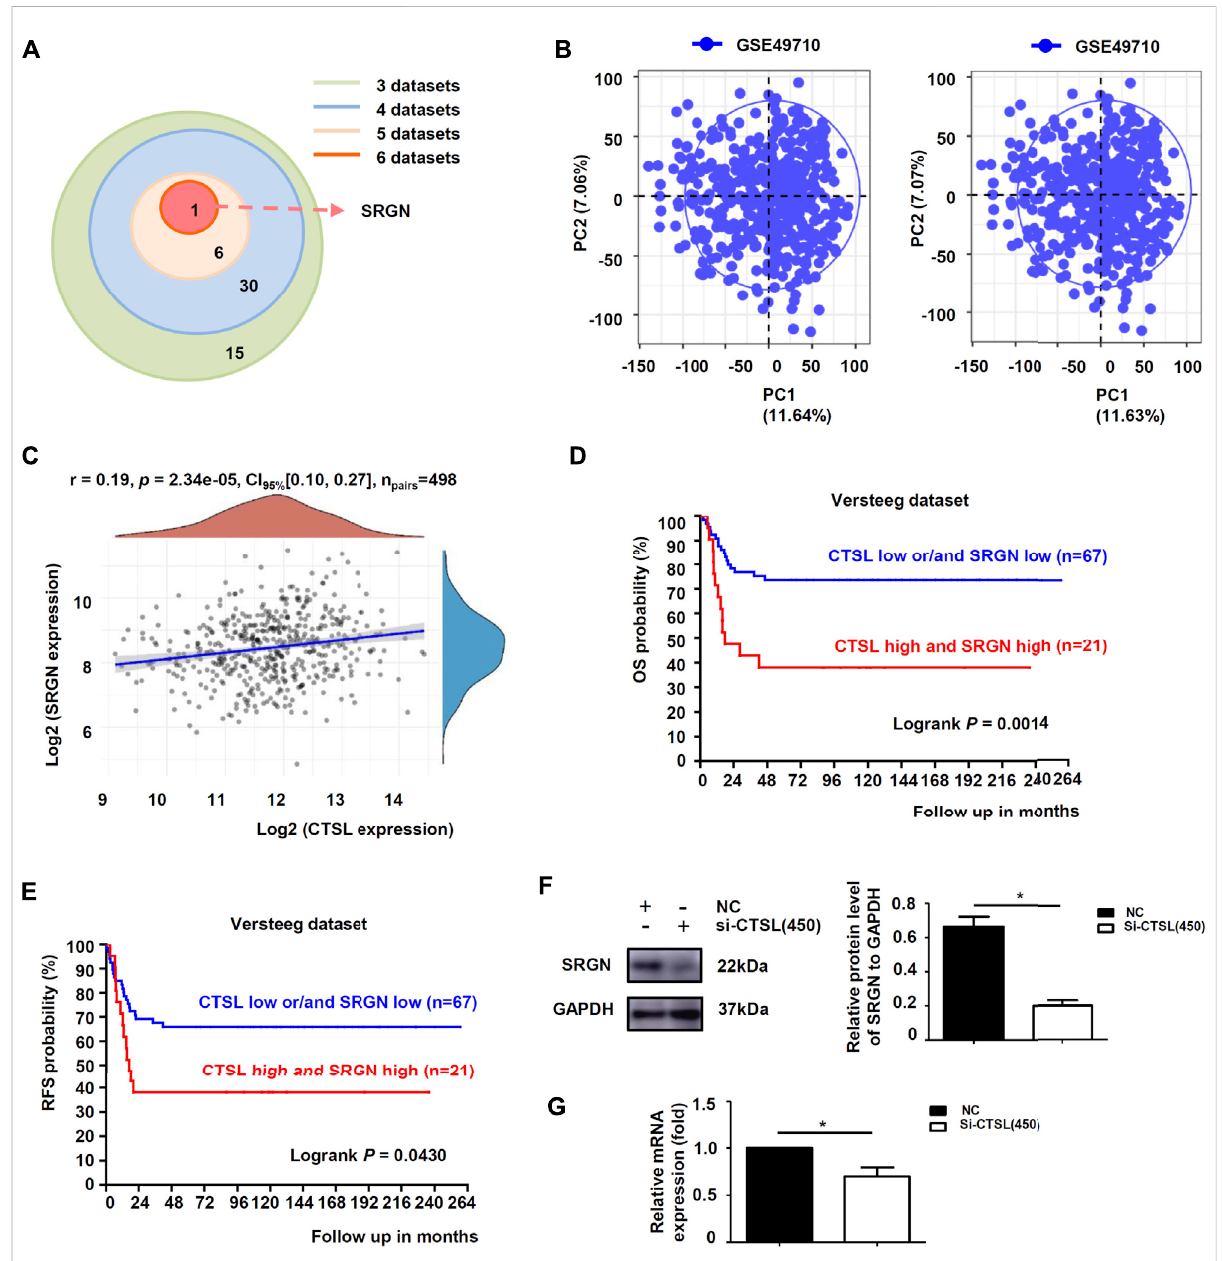
FIGURE 6 CTSL inducedchemoresistance byup-regulating theexpression of SRGN inNB cells (A) Overlap amongthe sets of positively-correlated genes of CTSL in NB identi fi ed by the six datasets (Tumor Neuroblastoma — Seeger — 117 — DCHIP; Westermann — 144 — tpm; Fischer — 223 — custom; Jagannathan — 100 — custom;Maris — 101 — custom;SEQC — 498 — custom) (B) Principalcomponentanalysis(PCA)resultbeforebatchremovalforthe dataset GSE49710 was show in the left, and PCA result after batch removal was show in the right (C) Correlation between CTSL and SRGN expression in 498 NB samples from GSE49710 dataset (D) Kaplan-Meier analysis of overall survival (OS) and (E) Recurrence-free survival (RFS) were determined according to CTSL/SRGN expression in 88 NB samples from Versteeg dataset. Statistical analysis was carried out using a log-rank test. Western blot analysis (F) and real-time quantitative PCR analysis (G) of SRGN levels in SK-N-BE (2) cells after CTSL silencing. *, p <